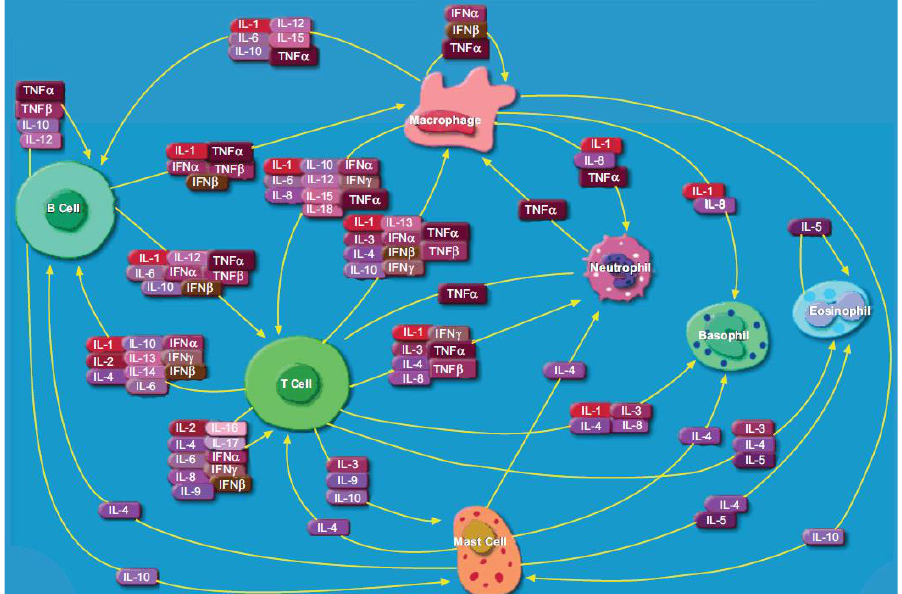
Figure 1. Metabolic pathways of cytokines in humans. Reprinted from [4] with permission from PubMed Central.